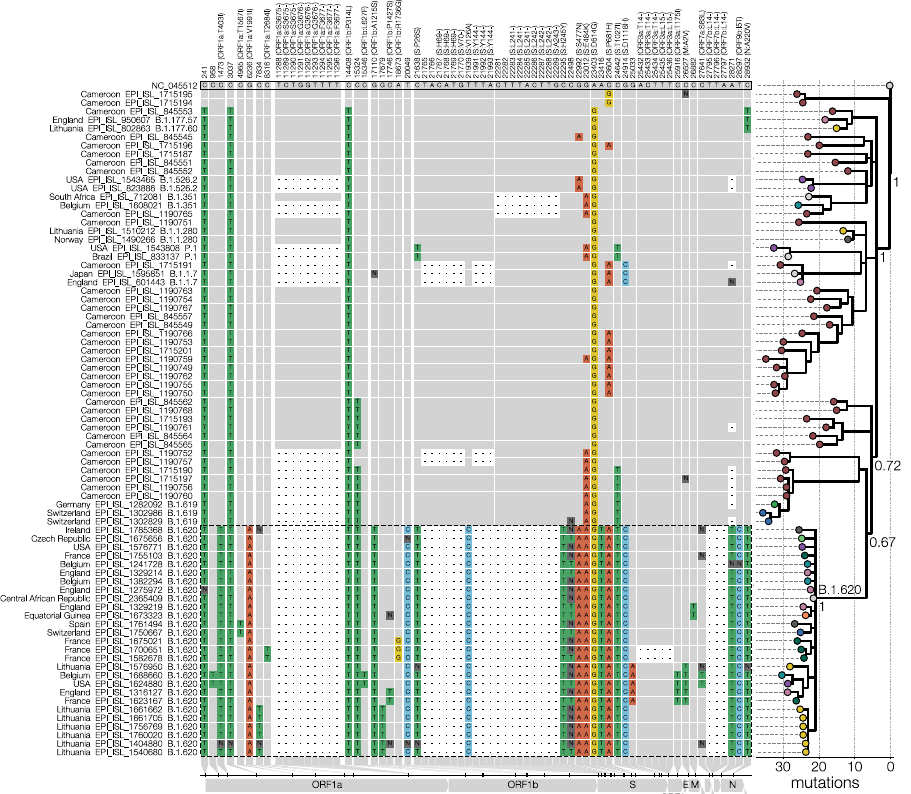
Fig. 1 Lineage-de fi ning SNPs of lineage B.1.620. Only SNPs that differentiate B.1.620 (genomes outlined with a dashed line) from the reference (GenBank accession NC_045512) and that are shared by at least two B.1.620 genomes are shown in the condensed SNP alignment. Sites identical to the reference are shown in grey, changes from the reference are indicated and coloured by nucleotide (green for thymidine, red for adenosine, blue for cytosine, yellow for guanine, dark grey for ambiguities, black for gaps). The fi rst 100 and the last 50 nucleotides are not included in the fi gure but were used to infer the phylogeny. If a mutation results in an amino acid change, the column label indicates the gene, reference amino acid, amino acid site, and amino acid change in brackets. The phylogeny (branch lengths in the number of mutations) on the right shows the relationships between depicted genomes and was rooted on the reference sequence with coloured circles at the tips indicating the country from which the genome came. Posterior probabilities of nodes leading up to lineage B.1.620 are shown near each node with the long branch leading to lineage B.1.620 labelled as ‘ B.1.620 ’